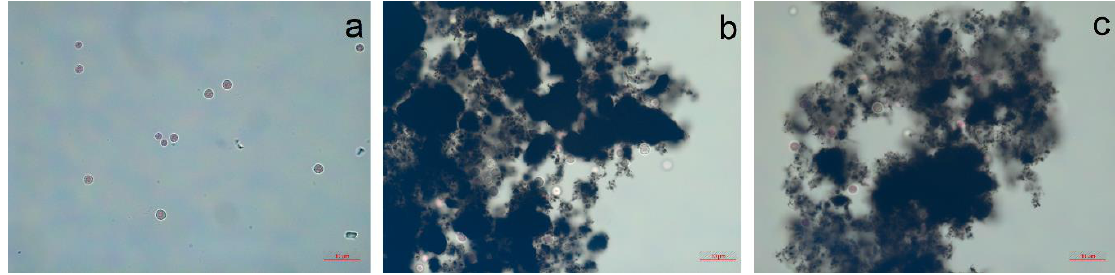
Figure 3. The red algae P. purpureum after 96 h of treatment with carbon nanotubes at concentration of 100 mg/L: ( a ) control; ( b ) CNT-1; ( c ) CNT-2.